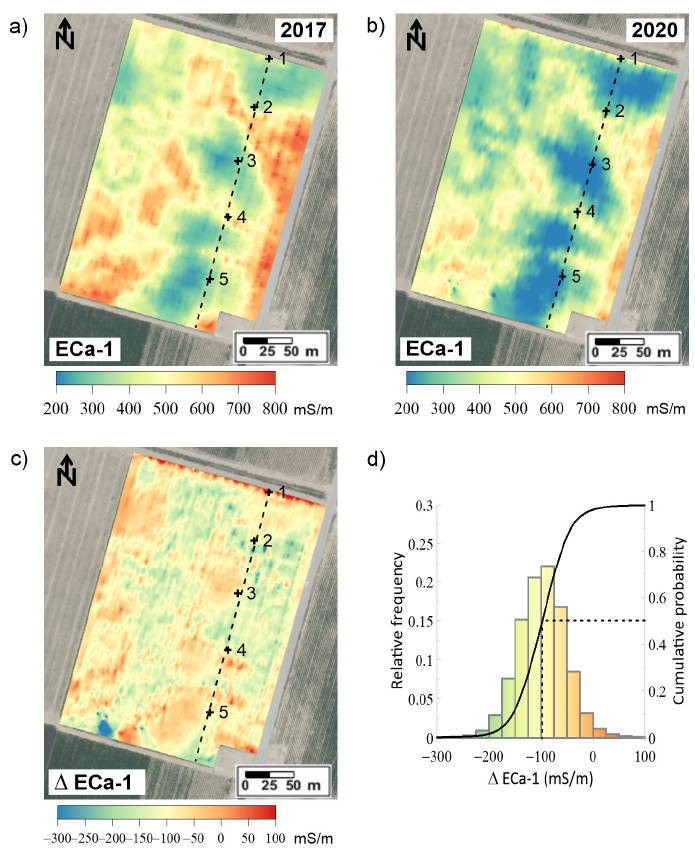
Figure 5. Spatial distribution of ECa-1 in ( a ) 2017 and ( b ) 2020; ( c ) Increments of ECa-1 from 2017 to 2020 ( Δ ECa-1); and ( d ) histogram and cumulative distribution of Δ ECa-1.